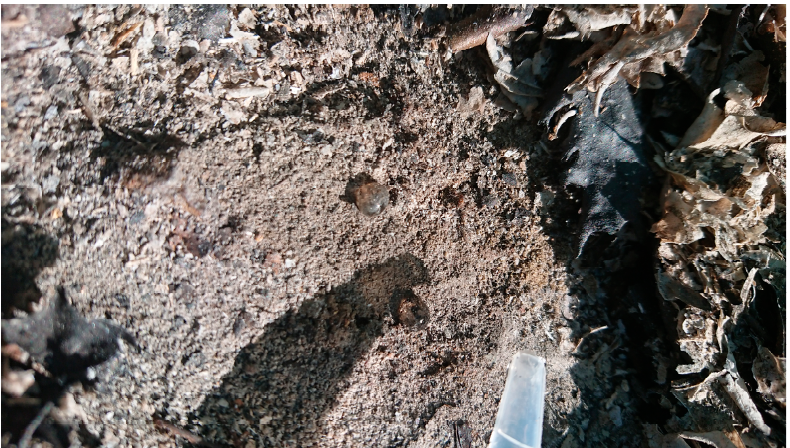
Figure A4. Measurements of soil water repellency (by the WDPT method) in the experimental site (Samo, Calabria, Southern Italy).